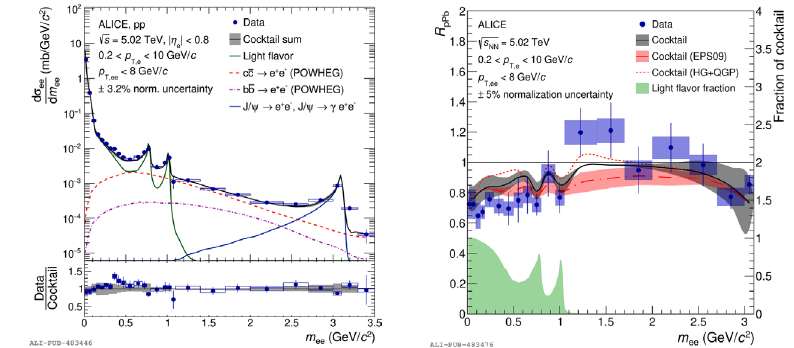
Figure 1. Left: dielectron production in pp collisions at √ s = 5.02 TeV compared to the expectations from known hadronic decays[1]. Right: dielectron nuclear modification factor in p–Pb collisions at = 5.02TeV compared to √ s NN